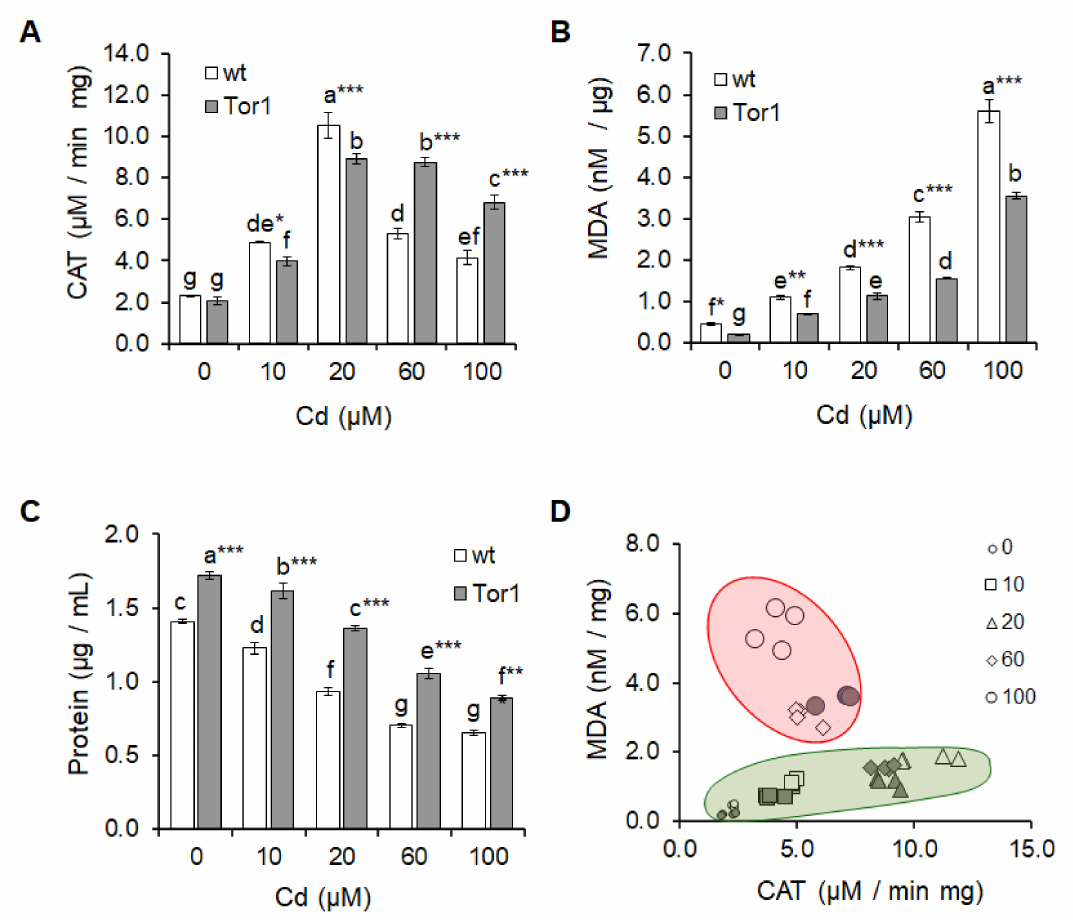
Figure 4. Cd-mediated oxidative stress is noticeably reduced in Tor1-null cells. Bars represent the mean values ± SD ( n = 8) of catalase (CAT) activity ( A ), malondialdehyde (MDA) content ( B ), and protein amounts ( µ g / mL) ( C ) of wild-type (wt, white bars) and Tor1-deficient (Tor1, grey bars) cells supplemented with di ff erent CdCl 2 concentrations for 3 h. Statistical significance is represented by asterisks (*). Number of * represents statistical significance and is determined as p < 0.05 *, 0.01 **, 0.001 ***; the same letters above bars indicate that these mean values are not significantly di ff erent. ( D ) Graphical illustration demonstrates the degree of Cd toxicity in correlation with the protective capacity of the two tested strains. The green circle depicts the “protective zone”, while the red circle depicts the “zone of